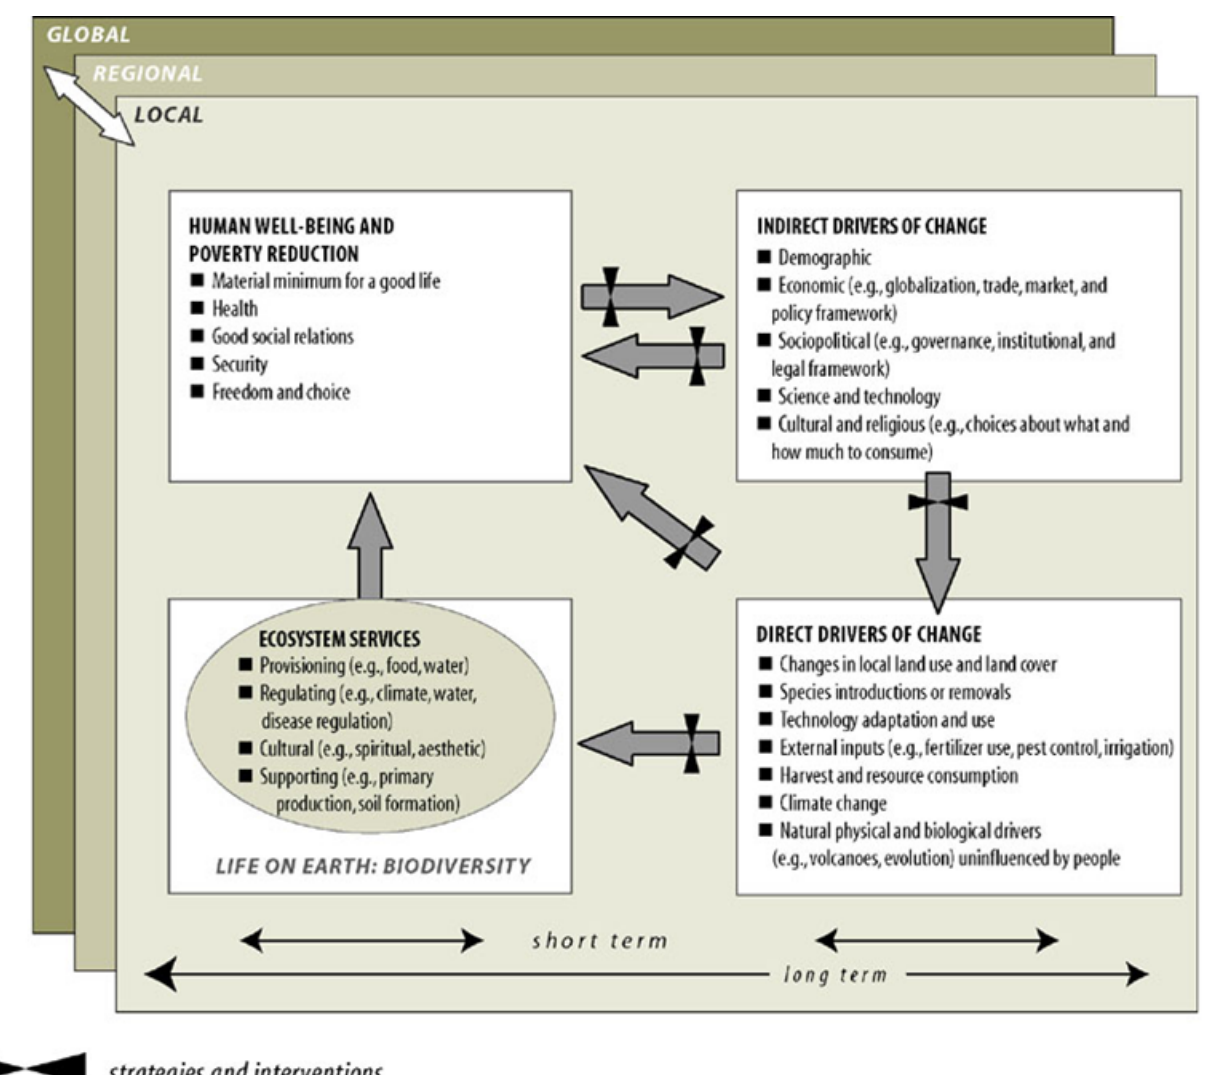
Fig. 1 . The Millennium Assessment Conceptual Framework (Millennium Ecosystem Assessment